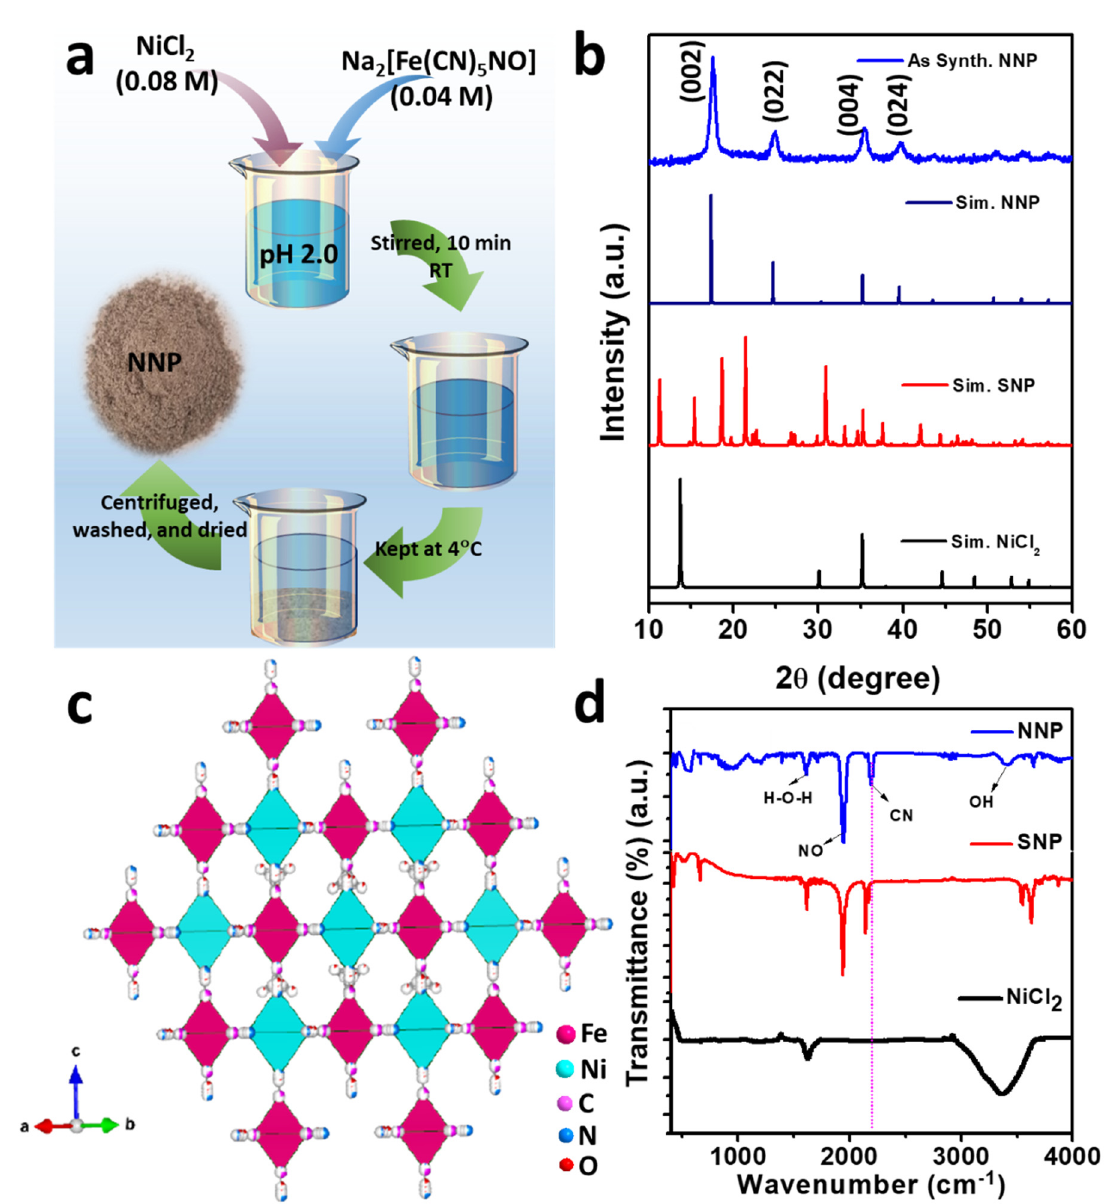
Figure 1. ( a ) Schematic of the synthesis of NNP, ( b ) XRD patterns of the as-prepared NNP together with the simulated patterns of NiCl 2 , SNP, and NNP, ( c ) crystal structure of NNP, and ( d ) FTIR spectra of NiCl 2 , SNP, and NNP.